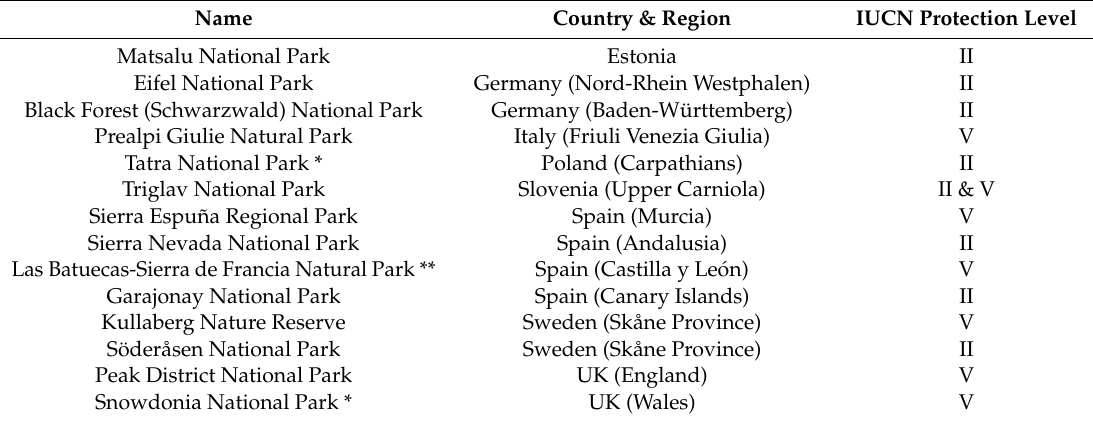
Table 1. Nature Protected Areas (PAs) participating in the